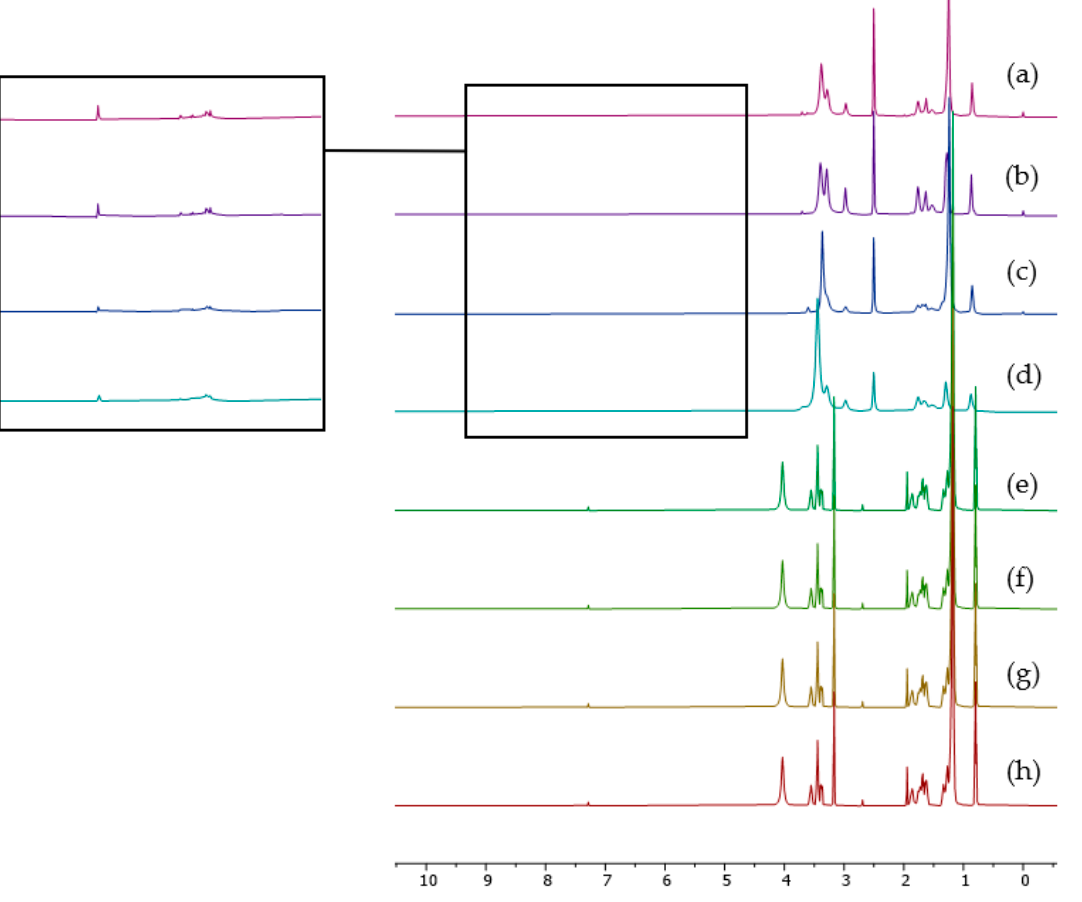
Figure 2. NMR spectra of synthesized cations and ILs. (a) [C 6 C 1 Pip] 2 [LS], (b) [C 8 C1Pip] 2 [LS], (c)